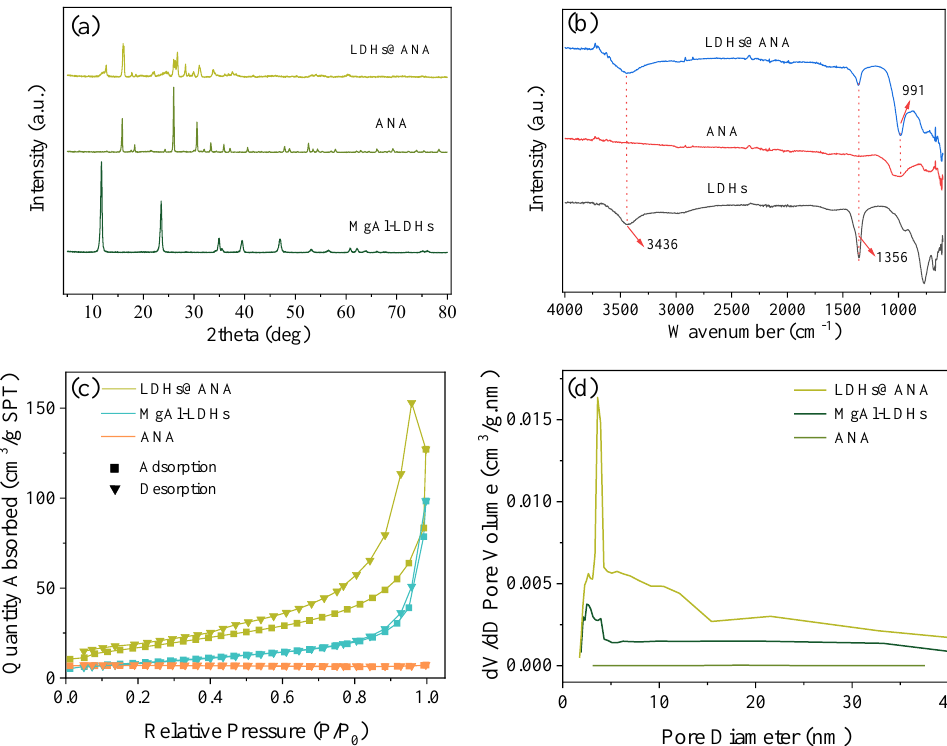
Figure 5. MgAl − LDHs, ANA, and LDHs@ANA of ( a ) XRD patterns, ( b ) FT − IR spectra, ( c ) N 2 Figure 5. MgAl−LDHs, ANA, and LDHs@ANA of ( a ) XRD patterns, ( b ) FT−IR spectra, ( c ) N 2 ad- adsorption-desorption isotherm curves, and ( d ) pore size sorption-desorption isotherm curves, and ( d ) pore size distribution.